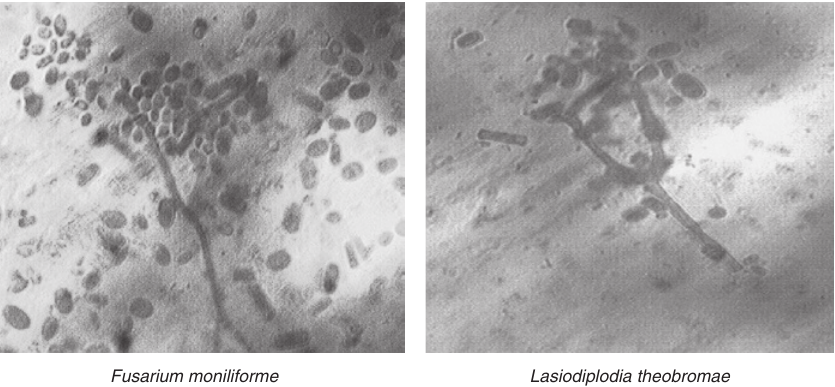
Figure 7: Microphotographs of the organisms associated with soft rot in yam tuber ( Dioscorea rotundata